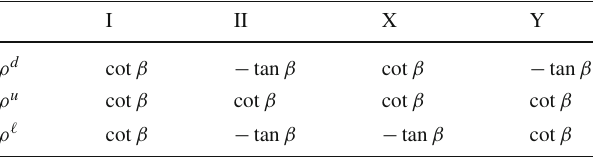
Table 2 ρ X factors corresponding to different